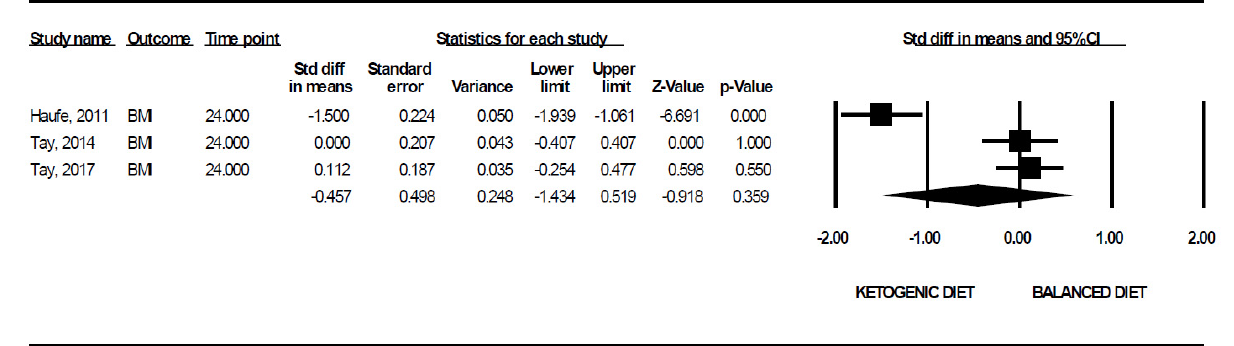
Figure 3. A forest plot of the effect of a ketogenic diet (KD) versus a balanced diet on body mass index (BMI), in kg/mt 2 .